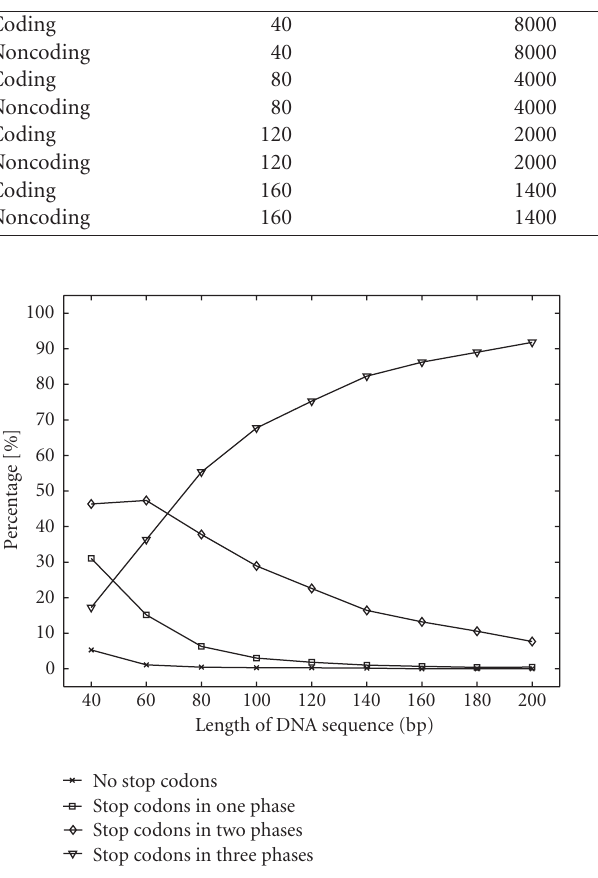
Figure 1: Distribution of stop codons along three phases in non- coding DNA regions.